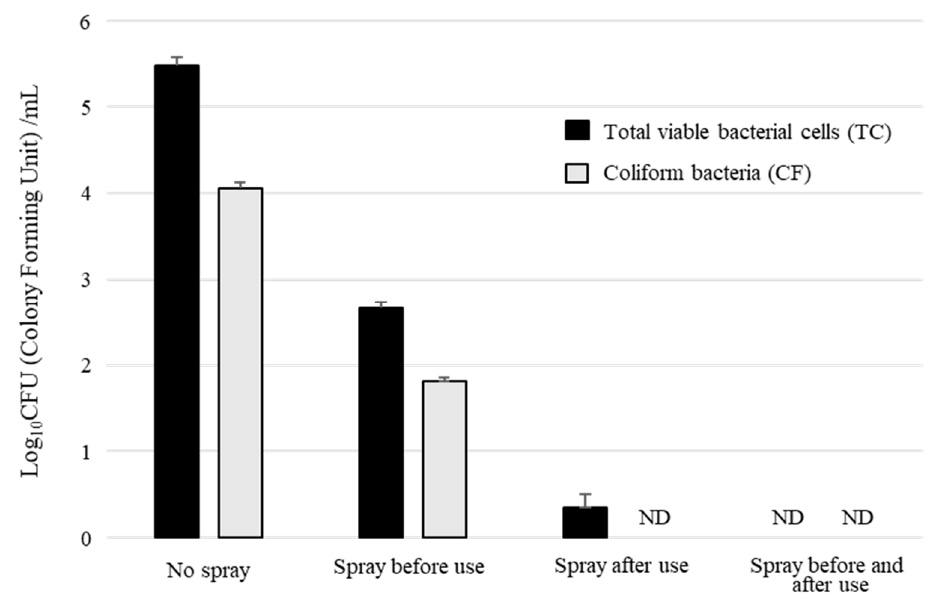
Figure 5. Sterilization of mask surfaces by spraying BiSCaO Water. Surgical masks coated with dry BiSCaO Water generated by spraying BiSCaO Water and drying had strong antimicrobial activity. BiSCaO Water sprayed on the contaminated surface of a surgical mask resulted in almost complete disinfection. The experiments were repeated four times.